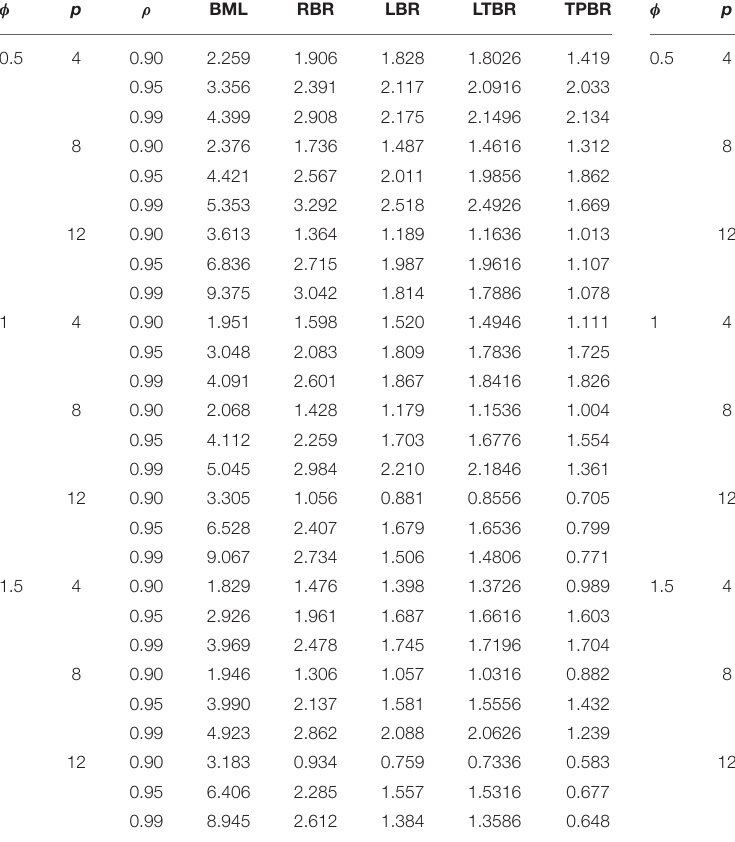
TABLE 2 | Mean squared error values for different estimators when n